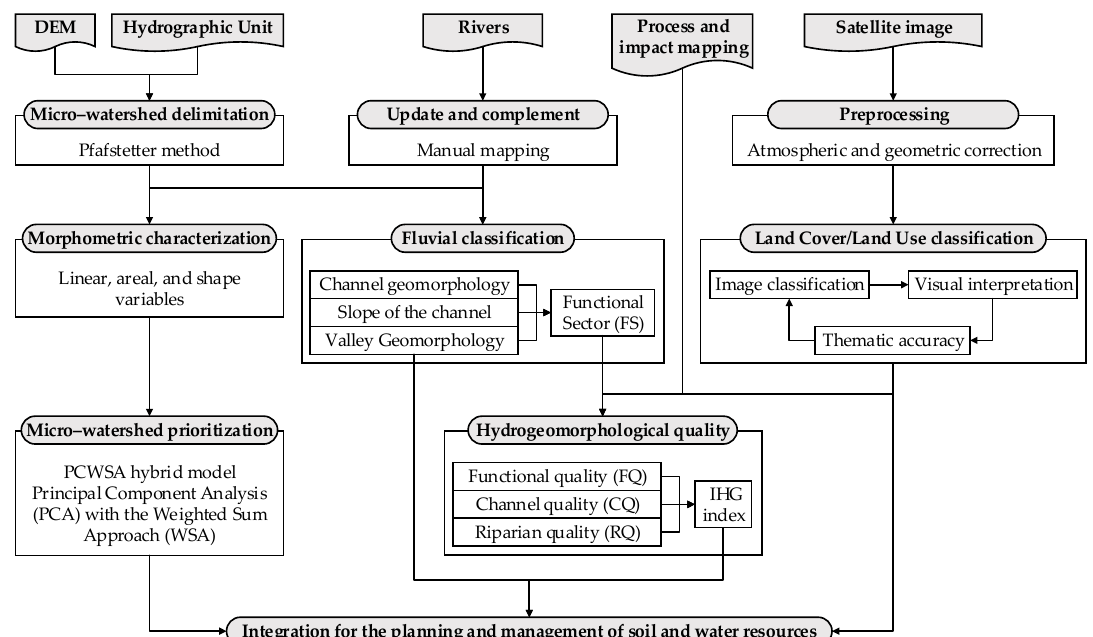
Figure 2. Flowchart of the integrated morphometric prioritization methodology, geomorphological fluvial classification, and hydrogeomorphological evaluation of hydrographic micro-watersheds.